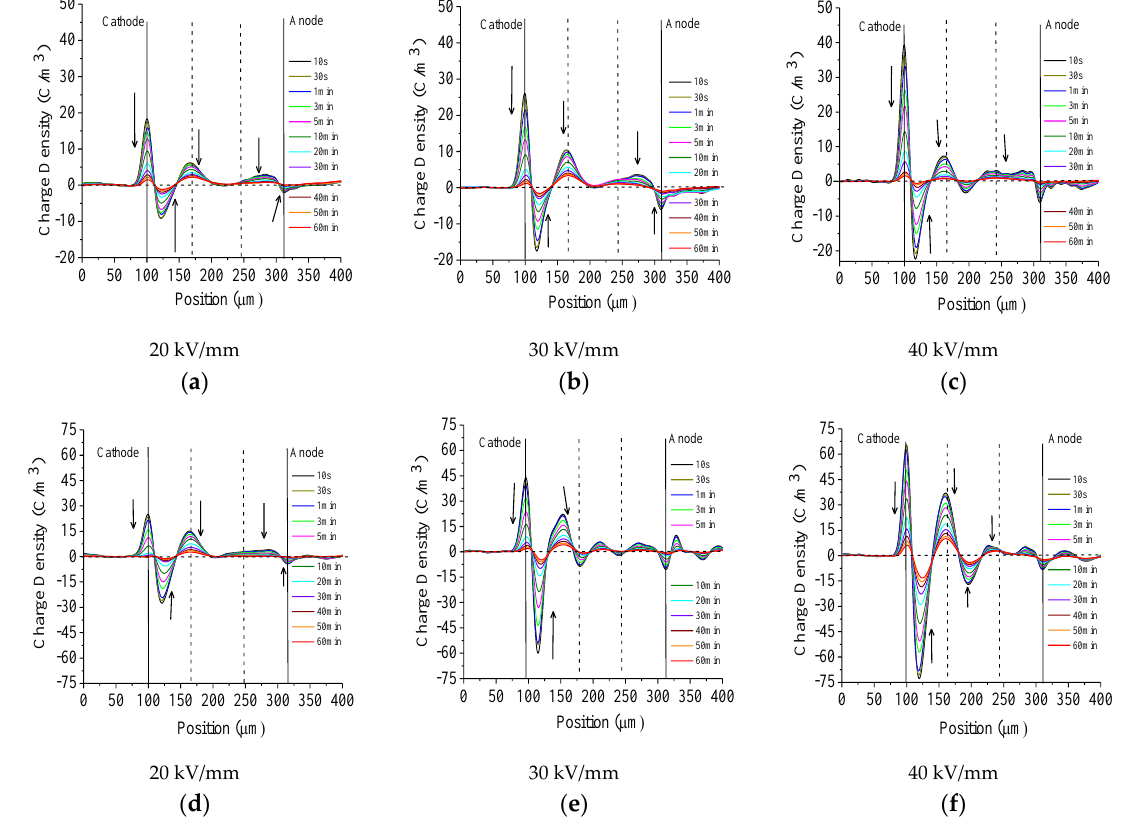
Figure 4. Space charge detrapping process for insulation paper immersed with new and aged oil under DC 20 kV/mm, 30 kV/mm, and 40 kV/mm. ( a ) space charge detrapping process for insulation paper immersed with new oil (20 kV/mm); ( b ) space charge detrapping process for insulation paper immersed with new oil (30 kV/mm); ( c ) space charge detrapping process for insulation paper immersed with new oil (40 kV/mm); ( d ) space charge detrapping process for insulation paper immersed with aged oil (20 kV/mm); ( e ) space charge detrapping process for insulation paper immersed with aged oil (30 kV/mm); ( f ) space charge detrapping process for insulation paper immersed with aged oil (40